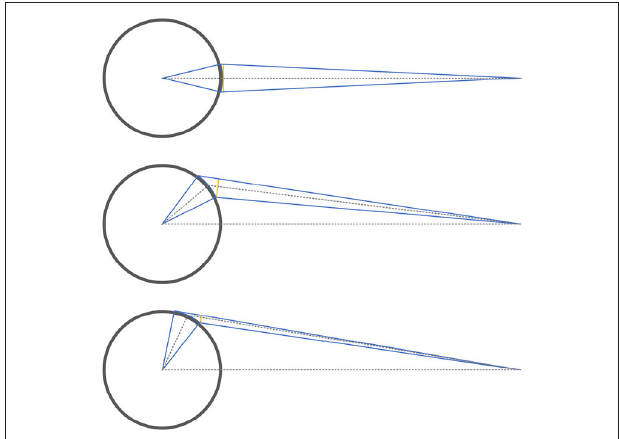
FIGURE 7 | Illustration of area radiation on a circular plane as it rotates away from the light source. The diffuse irradiance is equal through the circumference, while the amount of direct radiance decreases as the plant rotates away. To calculate this reduction of direct radiance, the reduction of the light opening (yellow bar) is calculated for every degree of rotation and then multiplied with the direct PAR at zero rotation.